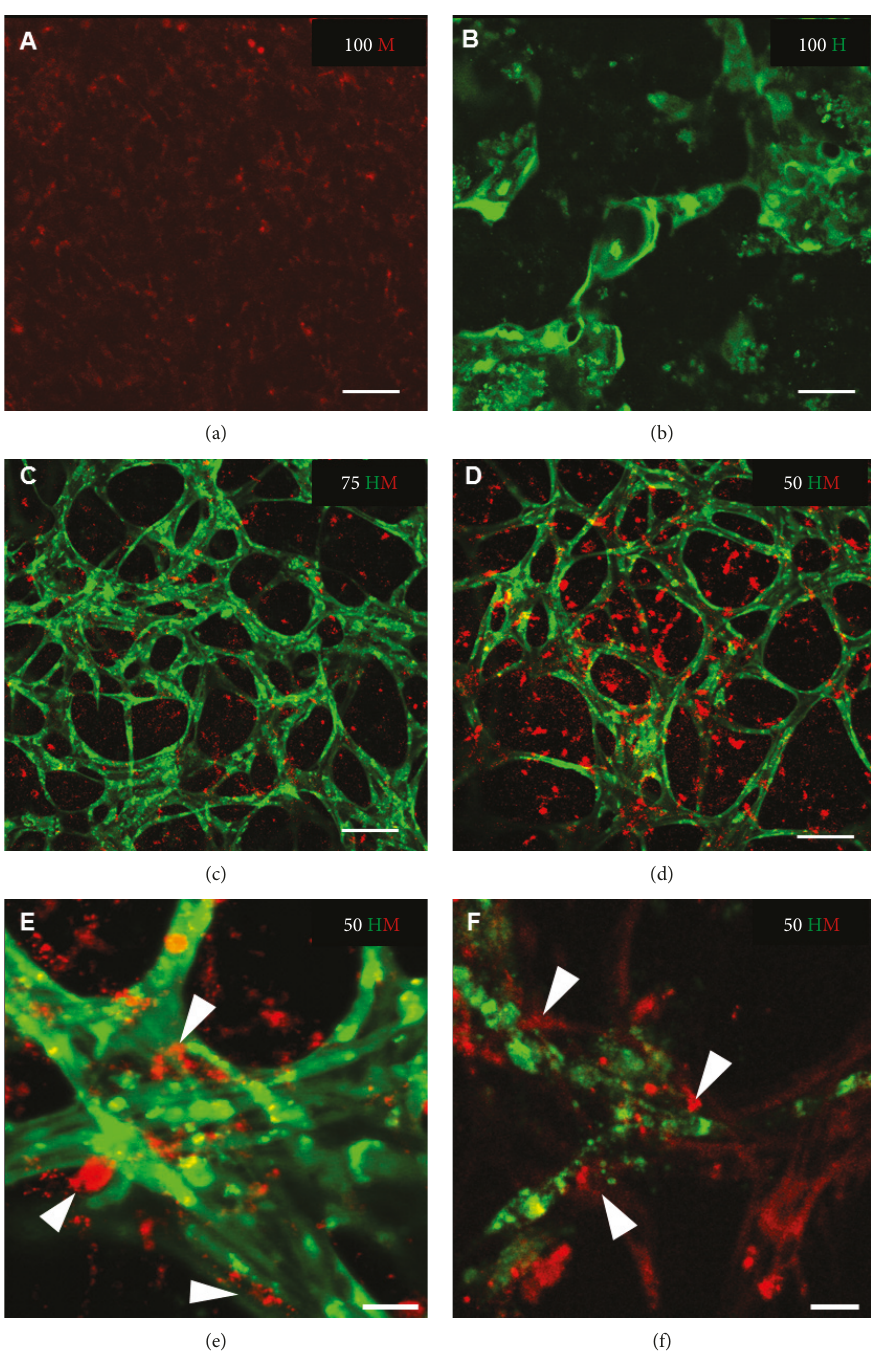
Figure 4: High-resolution images of HUVEC and MSC mono- and cocultures after 2 weeks. Representative images are shown from mono- and cocultures at day 14 after seeding (seeding density: 2.5 × 10 3 cells/ μ l gel) with (a) 100% MSCs (100M); (b) 100% HUVECs (100 H); (c) 75% HUVECs – 25% MSCs (75 HM); and (d – f) 50% HUVECs – 50% MSCs (50 HM). Network formation occurred in 100H and both cocultures but was only stable in the presence of MSCs which integrate in cellular networks as demonstrated in e and f (white arrow heads). Scale bar =100 μ m (a – d), 25 μ m (e,